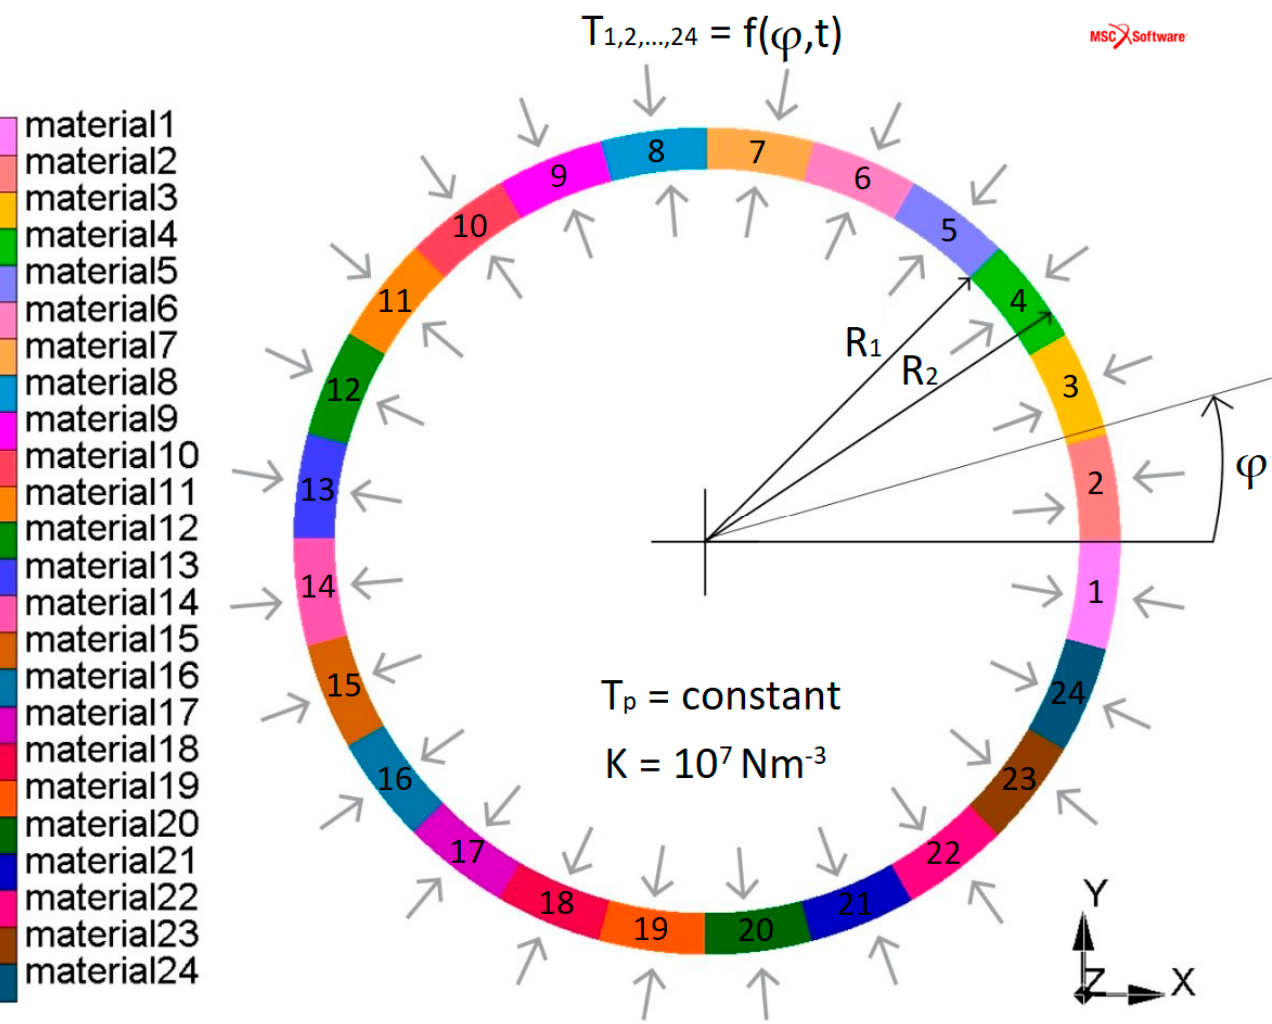
Figure 3. ‘Earthcylinder’ with materials and temperature loads (not to scale).